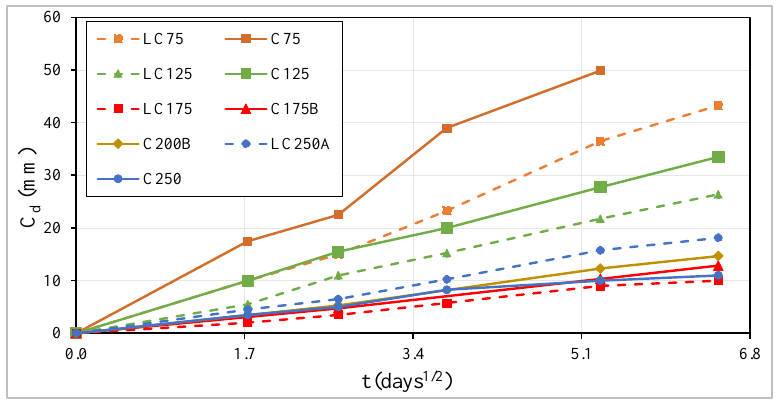
Figure 18. Carbonation depth vs. square root of time. Table 3. Results of carbonation depth, C d (mm).